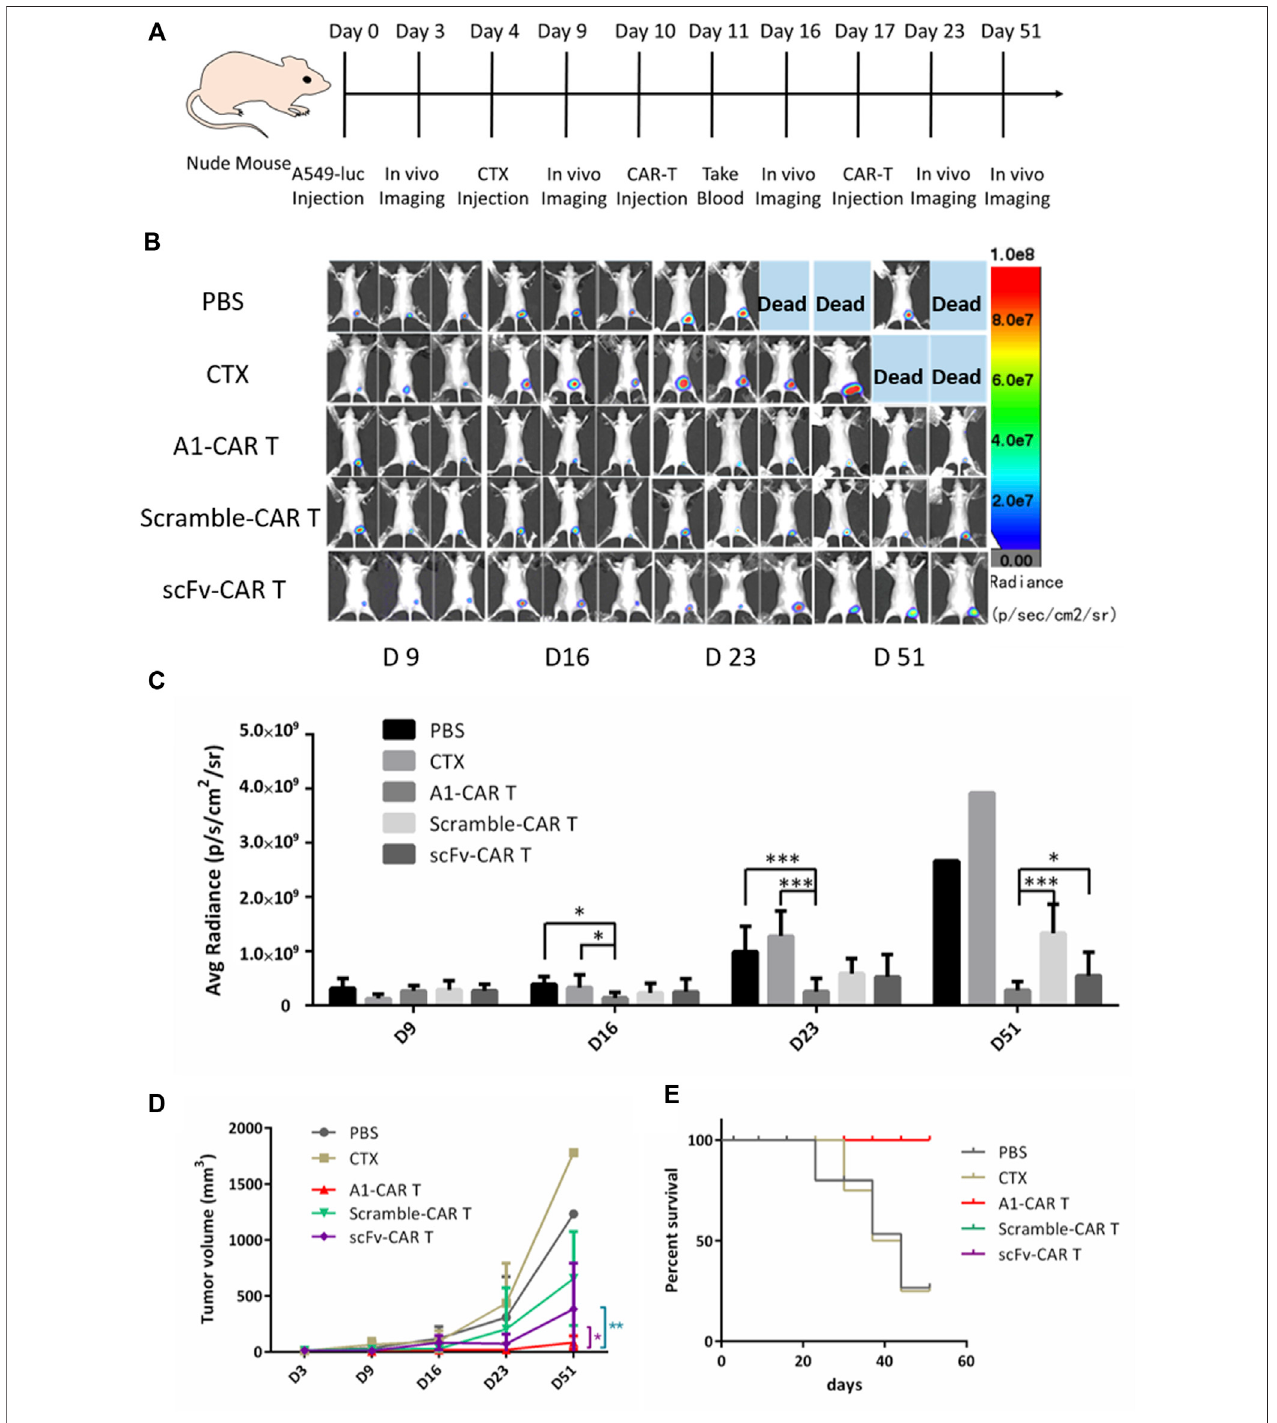
FIGURE3| Bispeci fi cCARsaremoreeffectiveininhibitingthegrowthofxenografttumors. (A) TheinjectionprocessofCARstothemicewithtumorxenografts. (B) A1-CARsdemonstratedpotentantitumor activityindicatedbybioluminescentimagingwiththeIVISLuminaIIsystem(PerkinElmer)everyweekforatotalof fi vetimes (C) The bioluminescence intensities in mice were measured. n = 4 mice. Values represent mean ± SD. p = 0.023 (D16, PBS vs. CTX + A1-CARs); p = 0.016 (D16, CTX vs. CTX+A1-CARs); p =3.5×10 – 4 (D23,PBSvs.CTX+A1-CARs); p =7.2×10 – 4 (D23,CTXonlyvs.CTX+A1-CARs); p =1.7×10 – 4 (D51,CTX+A1-CARsvs.CTX + Scramble-CARs); p = 0.03 (CTX + A1-CARs vs. CTX + scFv-CARs). Calculated p values from two-sided Student ’ s t test. n = 4 mice/group. (D) The tumor volume averagemeasurementsand valuesofmice aremeasured.* p =0.019, ** p =0.009. n =4mice/group. T tests wereutilizedto decide the p values. (E) Survival ofthemice are